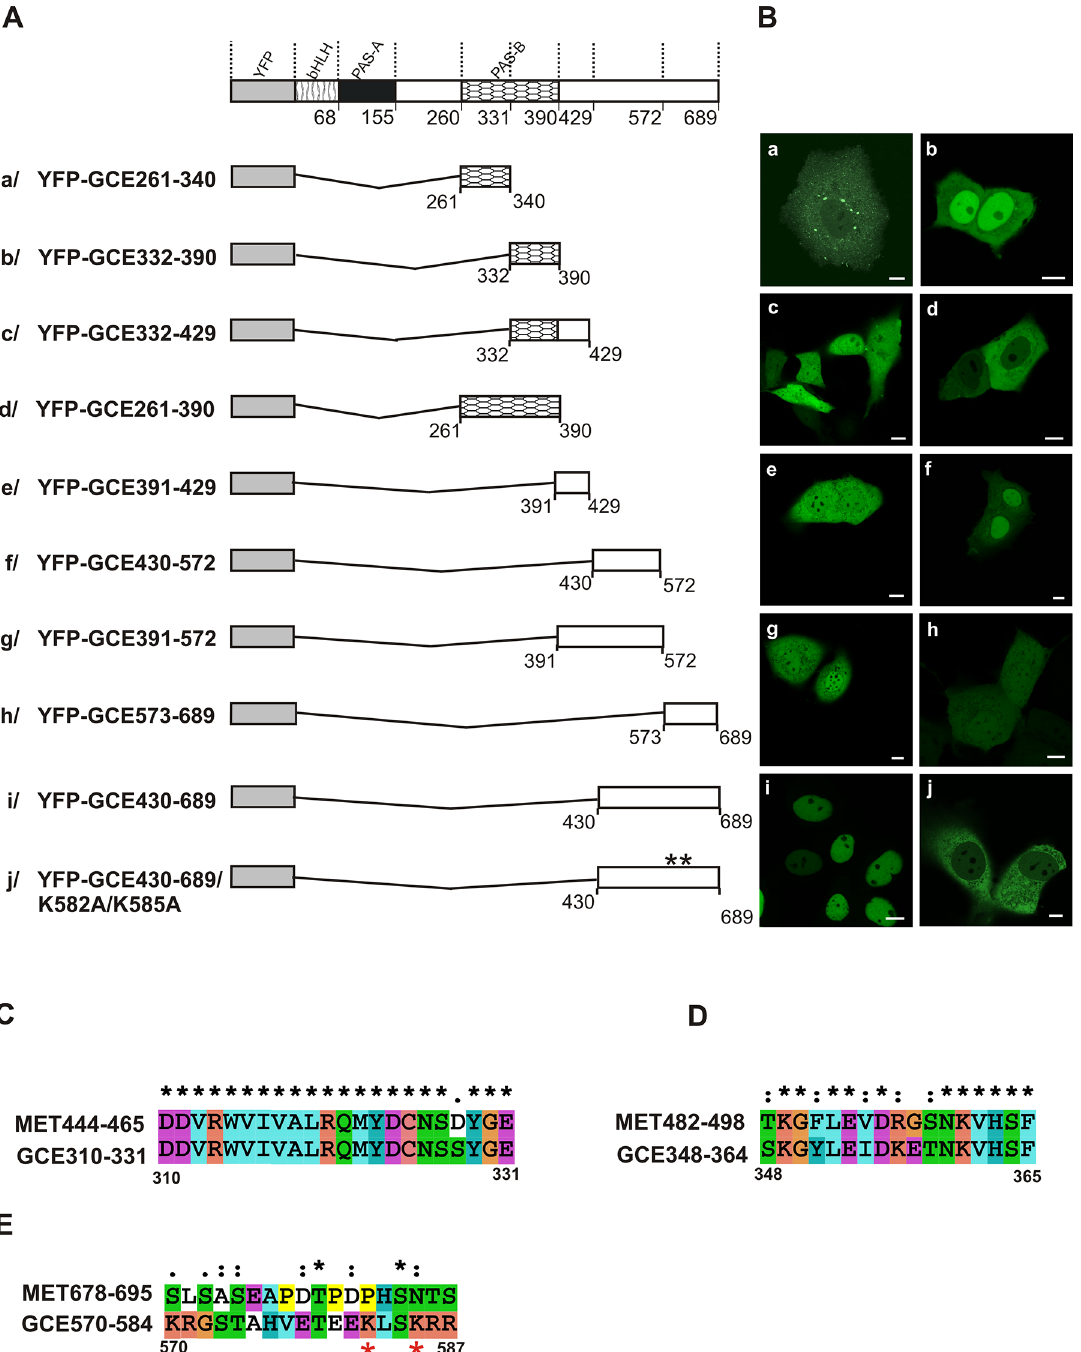
Fig 2. Subcellular distribution of the GCE mutants. Experiments identifying NLS and NES motifs in GCE, using a series of deletion mutants tagged with YFP revealed differentiated localization of truncated proteins. The subcellular localization of the expressed proteins was analyzed by confocal microscopy 20-24h after the transfection of COS-7 cells. (A) Schematic representation of the GCE derivatives. Regions of GCE are depicted using different patterns. The length of each domain in the diagram is arbitrary. (B) Representative images (single confocal plane) of the typical subcellular distribution of the GCE derivatives. Bar, 10 μ m. (C) ClustalX alignment of the MET444-465/GCE310-331 encompassing NES in PAS-B domain. (D) ClustalX alignment of the MET482-498/GCE348-364 encompassing NLS in PAS-B domain. (E) ClustalX alignment of the MET678-695/GCE570-584 encompassing NLS in C-terminal fragment of GCE. Asterisks indicate identical residues, and colons indicate similar residues. Residues numbered according to the sequence of GCE are given at the bottom of the alignment. Red asterisks indicate mutated residues.